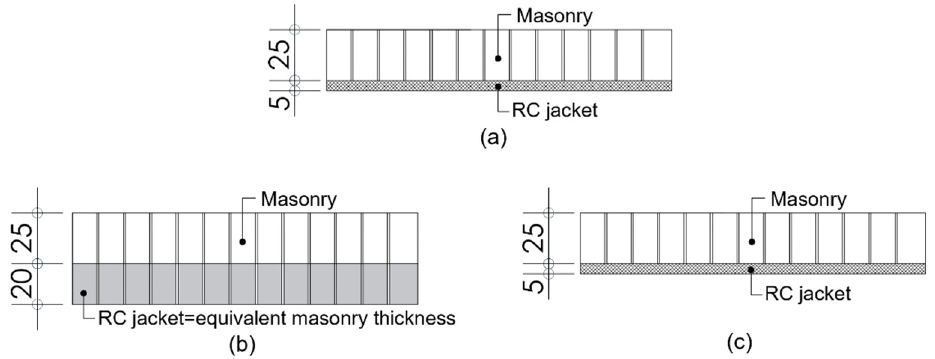
Figure 20. Numerical models for simulating RC jacketing: ( a ) actual wall section; ( b ) equivalent masonry section according to PTN-S, and ( c ) numerical model according to EC8-3. Numerical models for the original and retro fi tt ed structure are shown on Figure 21.